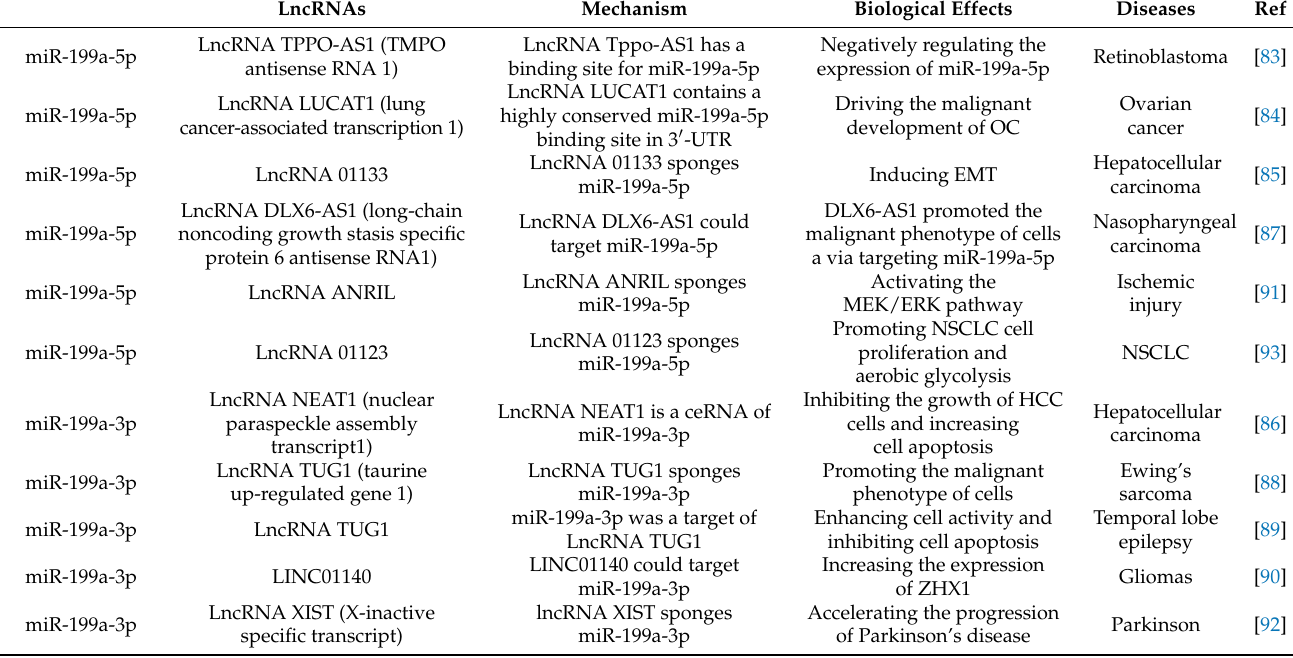
Table 4. Interplay between miR-199a and